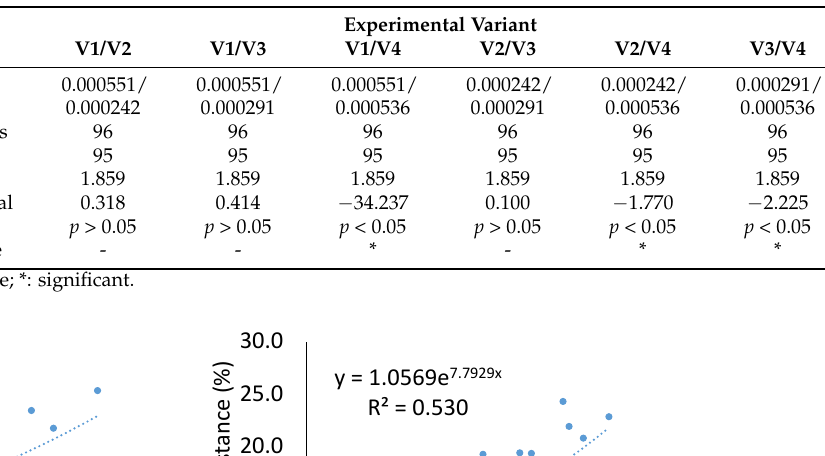
Table 2. Result summary of two-way t significance tests between four variants of experimental plot for density.